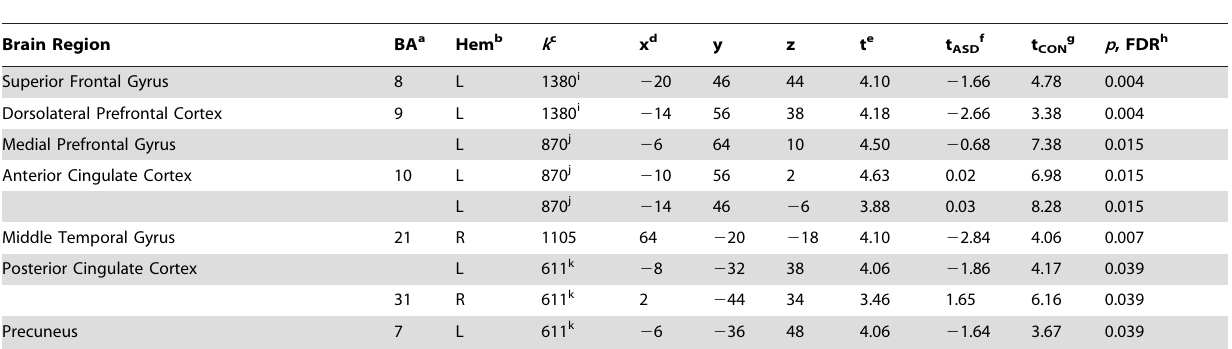
Table 2. Brain areas showing greater deactivation for control participants (n= 14) compared to participants with ASD (n=13) for the contrast of rest . ToM task (p , 0.005 uncorrected, FDR cluster-corrected).